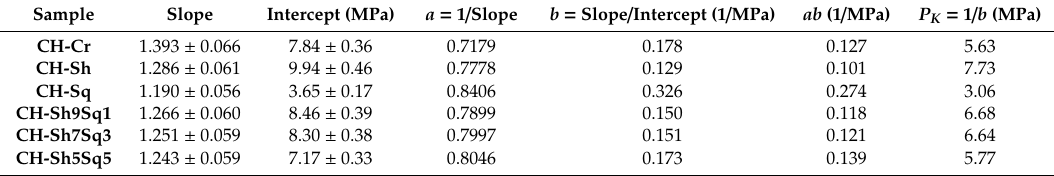
Table 6. Heckel parameters of CH-Cr, CH-Sh, and CH-Sq and their mixtures.